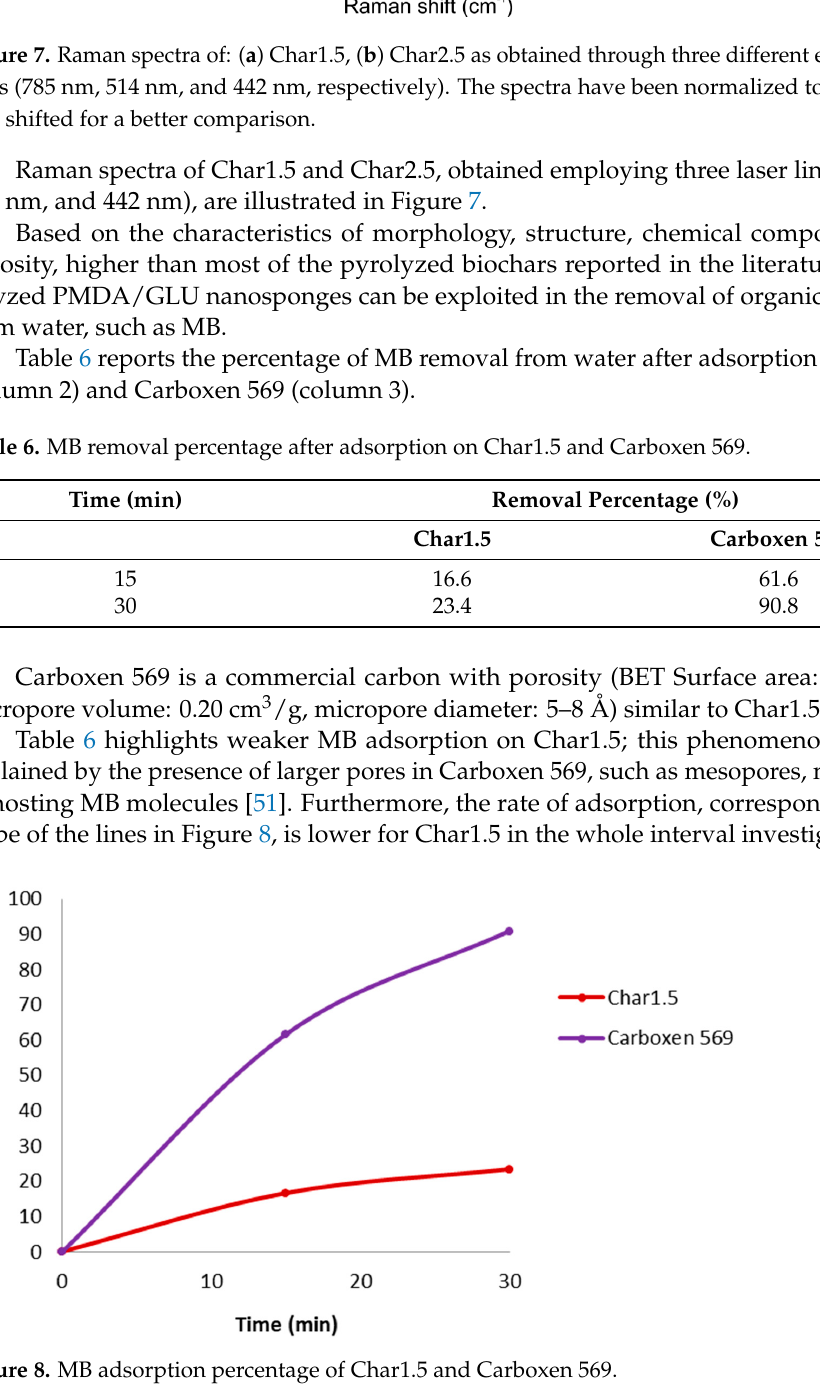
Figure 7. Raman spectra of: ( a ) Char1.5, ( b ) Char2.5 as obtained through three different exciting laser lines (785 nm, 514 nm, and 442 nm, respectively). The spectra have been normalized to the G-band and shifted for a better comparison.